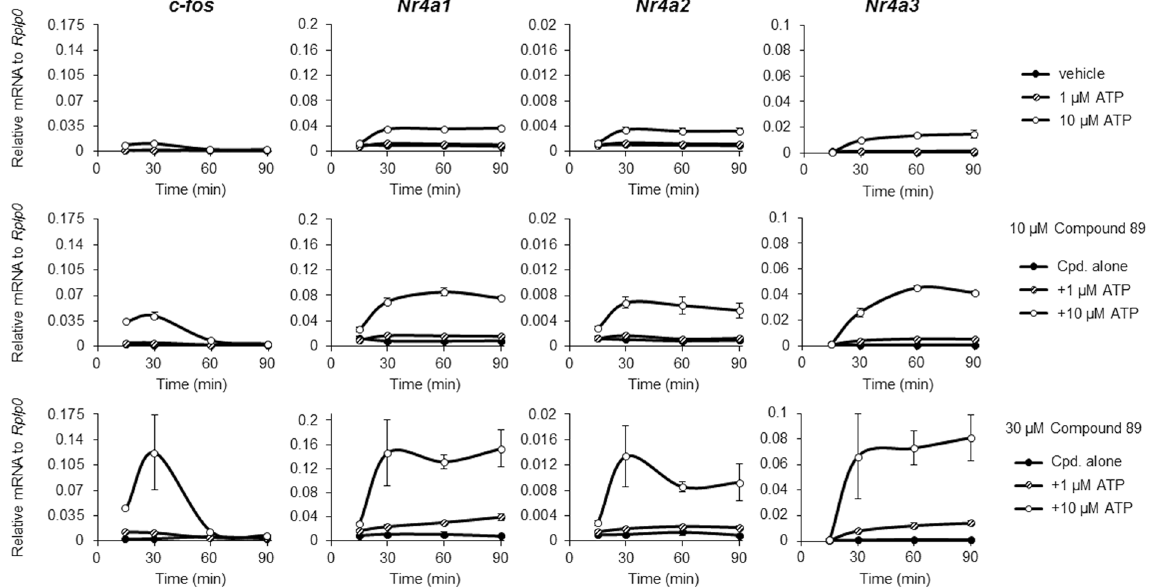
Figure 3. Compound 89 allosterically potentiates ATP-induced changes in IEG gene expression in cardiomyocytes. Gene expression changes of IEGs, c-fos and the NR4A subfamily, in a time-dependent manner. Inductions by ATP (0, 1 or 10 μ M) in the presence of Compound 89 (0, 10 or 30 μ M) were plotted. Expression levels are normalized to Rplp0 and shown as means ± SEM (n =